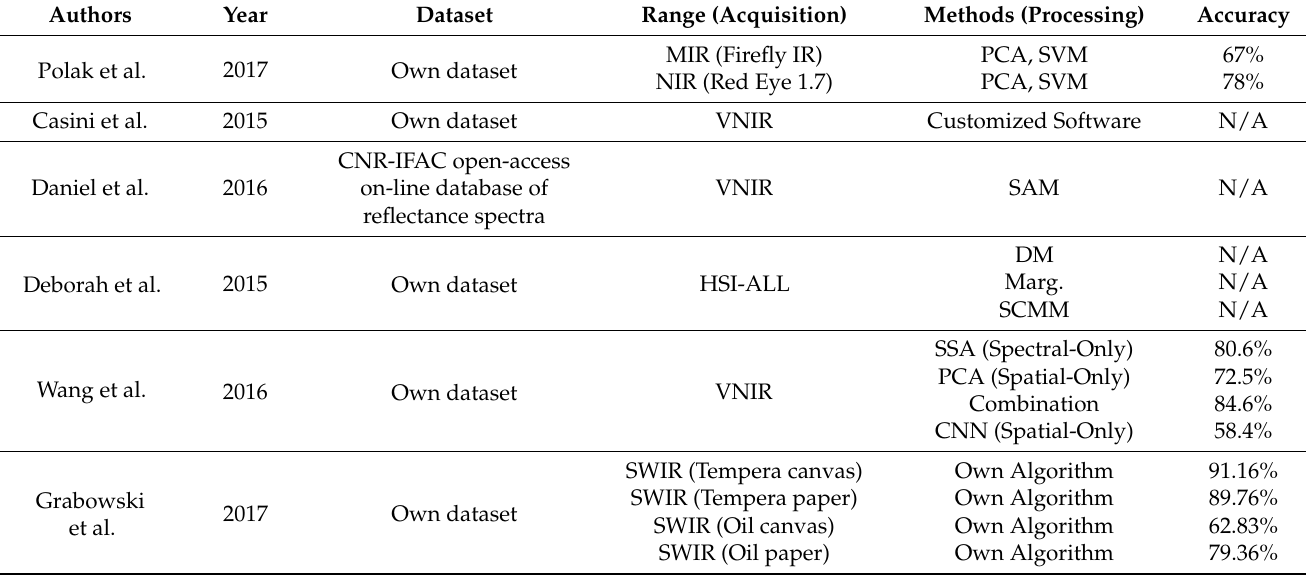
Table 1. Comparison of studies